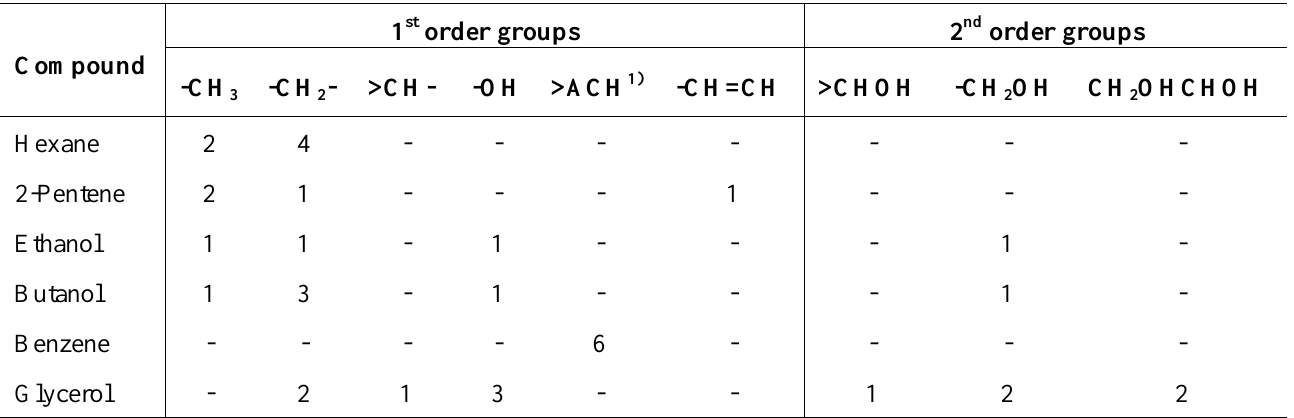
Table 3. UNIFAC structure for some molecules 1 st order